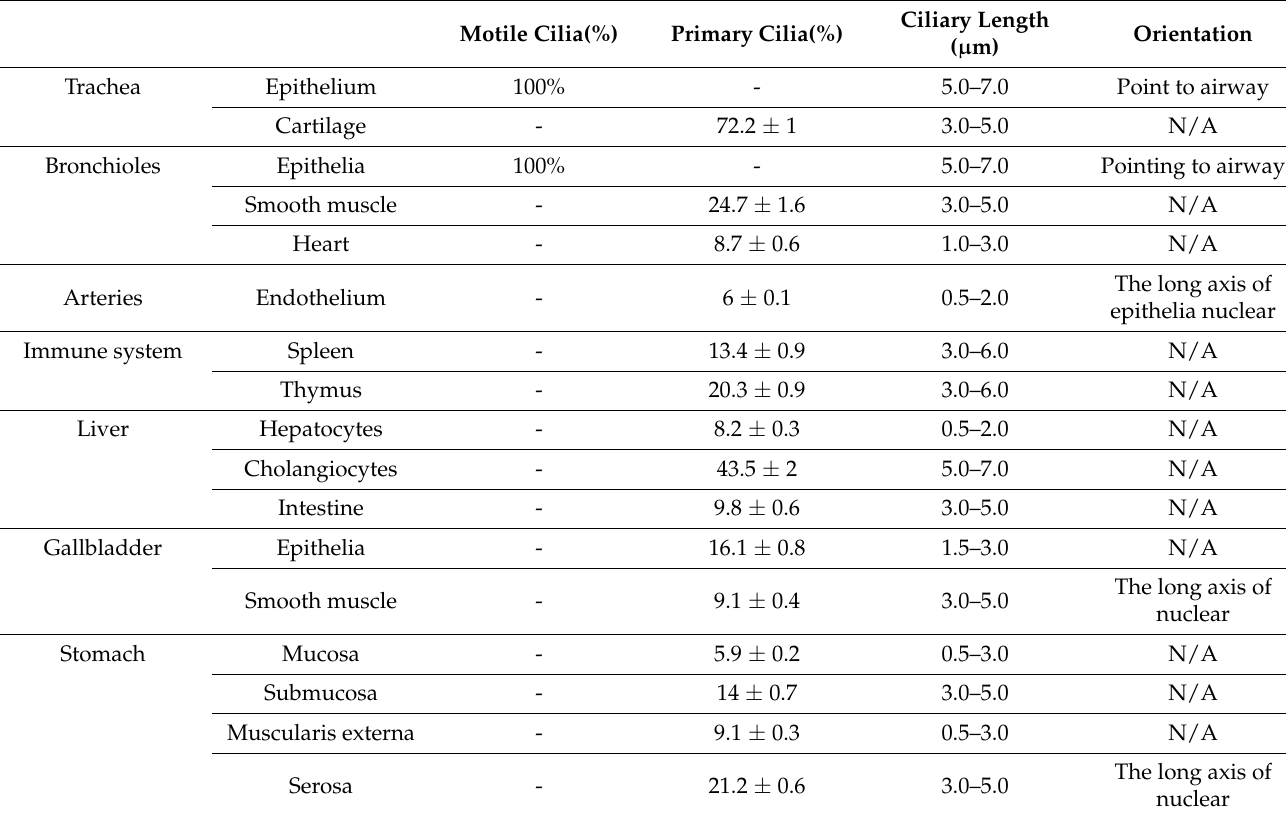
Figure 1. Cilia are present in different tissues of the respiratory system, circulatory system and immune system. ( A ) Trachea, ( B ) bronchioles, ( C ) heart, ( D ) artery, ( E ) spleen, ( F ) thymus. White arrow, cilium with an ARL13B-mCherry+ axoneme and Centrin2-GFP+ basal body. Yellow arrow, cell with only ARL13B-mCherry. Red arrow, cell with only Centrin2-GFP. Green, Centrin2-GFP. Red, ARL13B-mCherry. Blue, DAPI. Scale bar, 10 µ m. Table 1. The cilia in each organ or